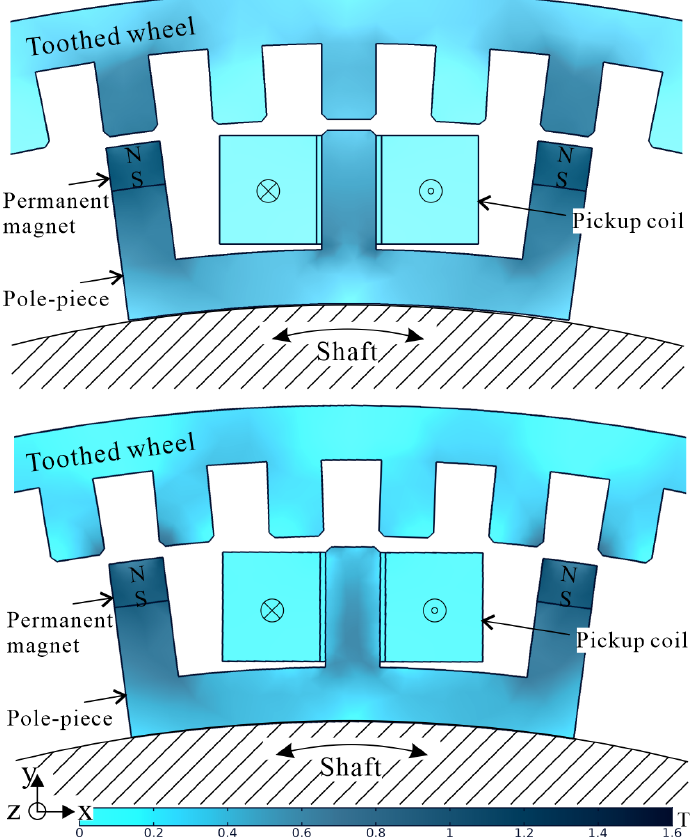
Figure 2. Magnetic flux density distribution of the VREH at the two extreme positions aligned position ( top ) and unaligned position ( bottom